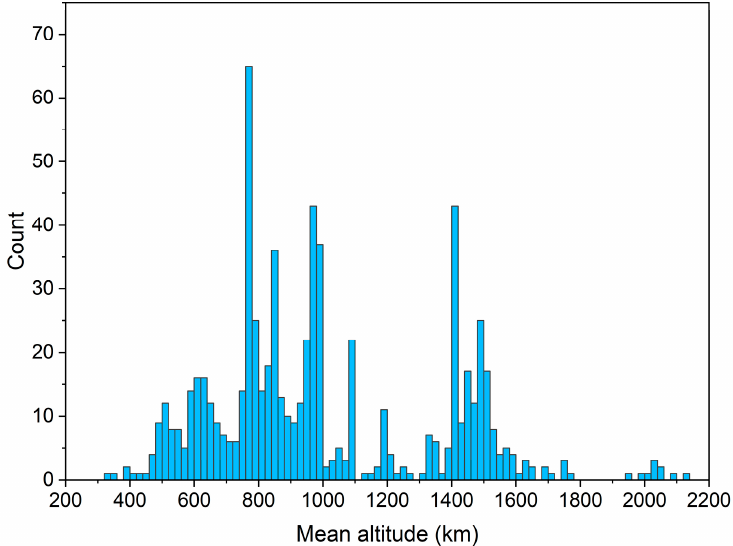
Figure 4. The mean altitude distribution of the 702 pieces of TLE-cataloged LEO space debris.